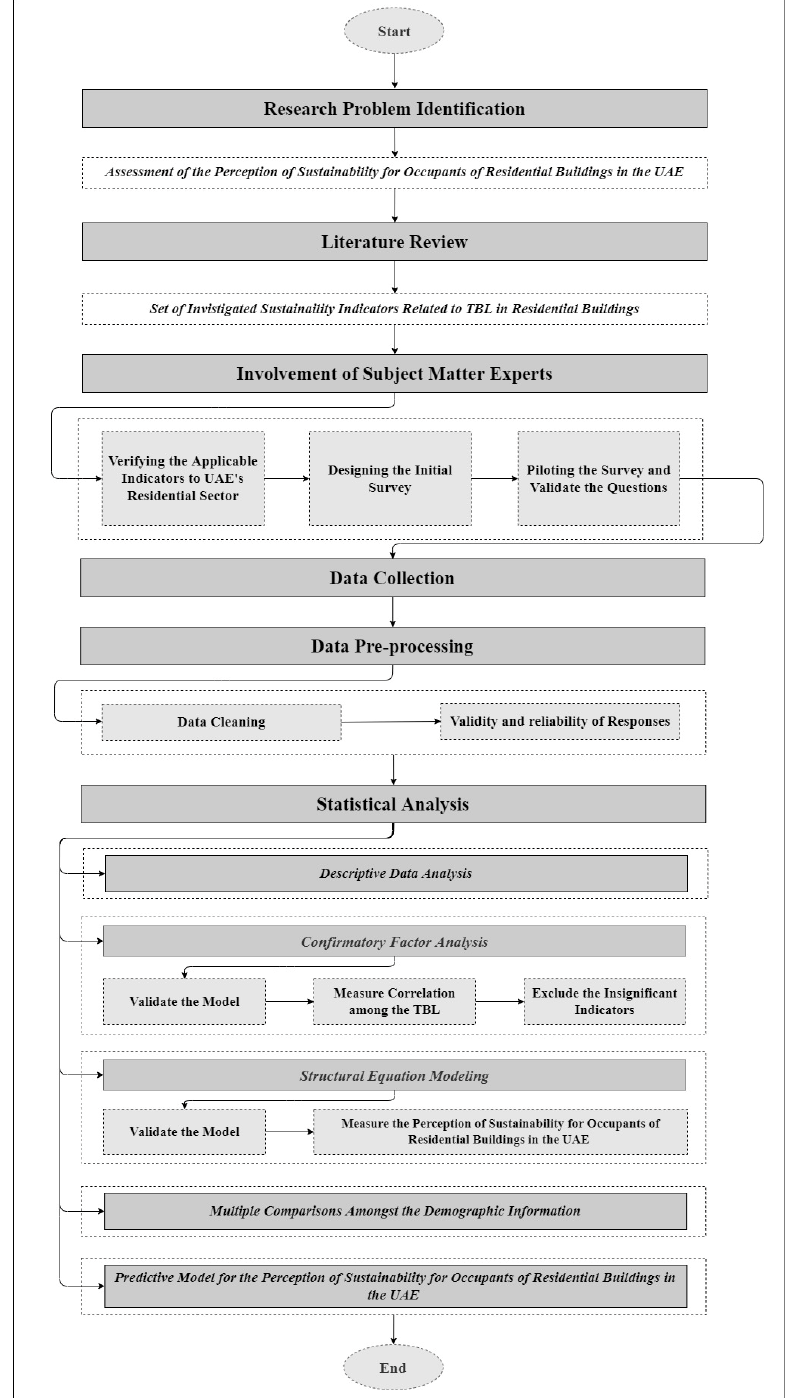
Figure 3. Research Methodology .